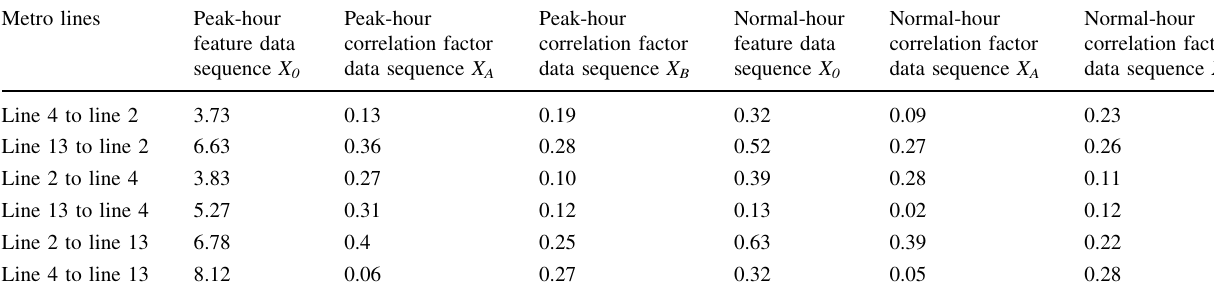
Table 7 The input data for calibration value calculation Metro lines